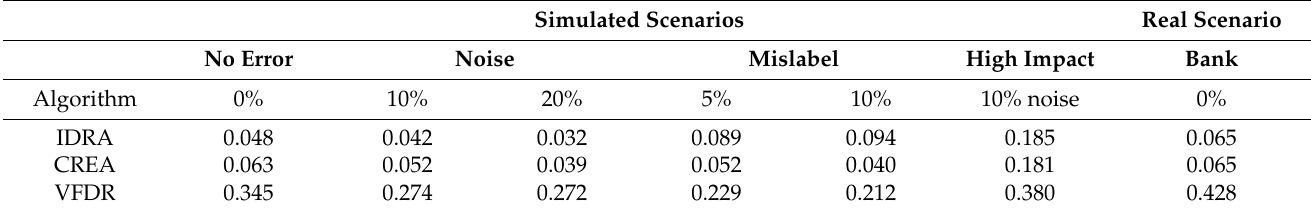
Table 5. Mean range of accuracy variability.